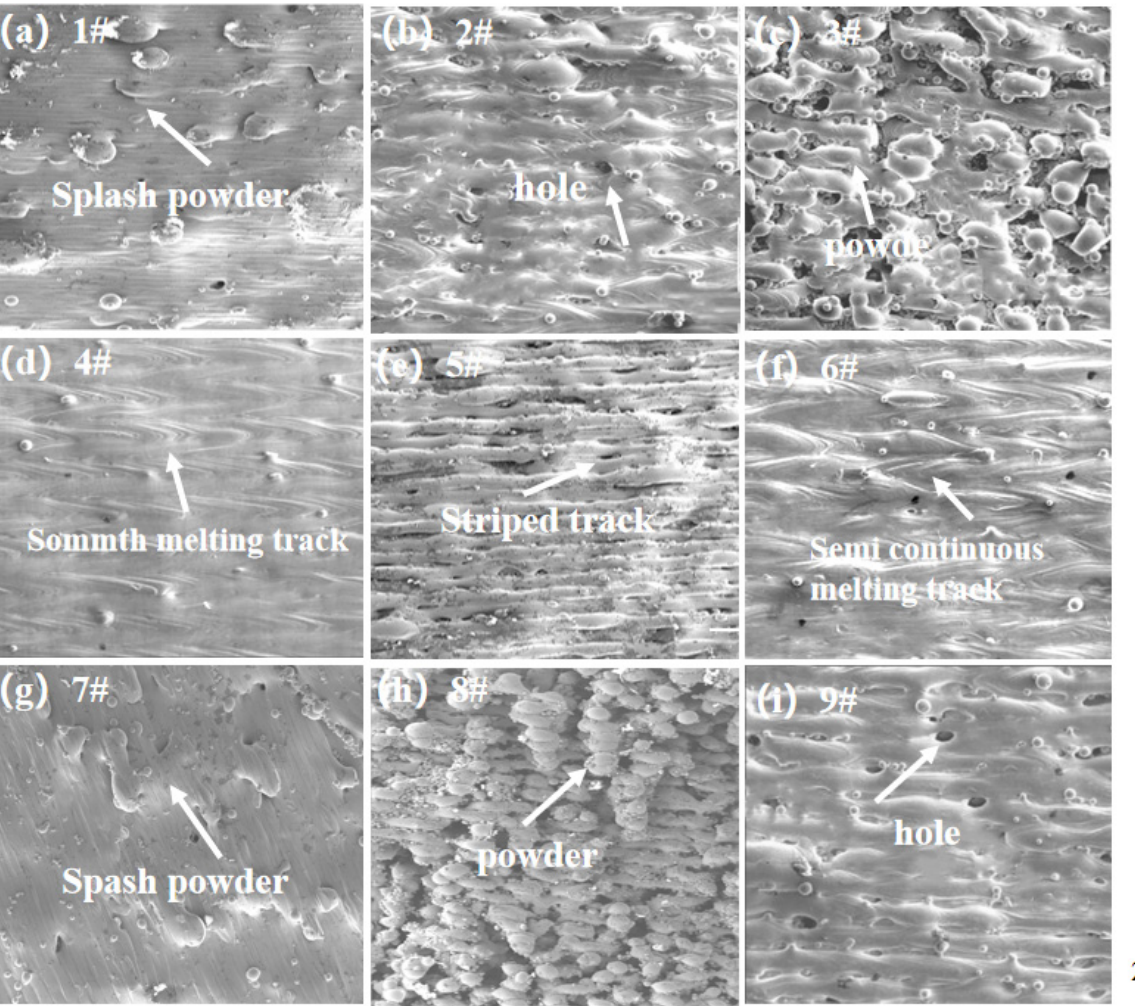
Figure 4. SEM micrographs showing top surface topography of as-receive samples fabricated at the energy density ( a ) 95.00 J/mm 3 , ( b ) 35.19 J/mm 3 , ( c ) 18.63 J/mm 3 , ( d ) 65 J/mm 3 , ( e ) 32.1 J/mm 3 , ( f ) 76.47 J/mm 3 , ( g ) 55.00 J/mm 3 , ( h ) 122.22 J/mm 3 and ( i ) 48.53 J/mm 3 .